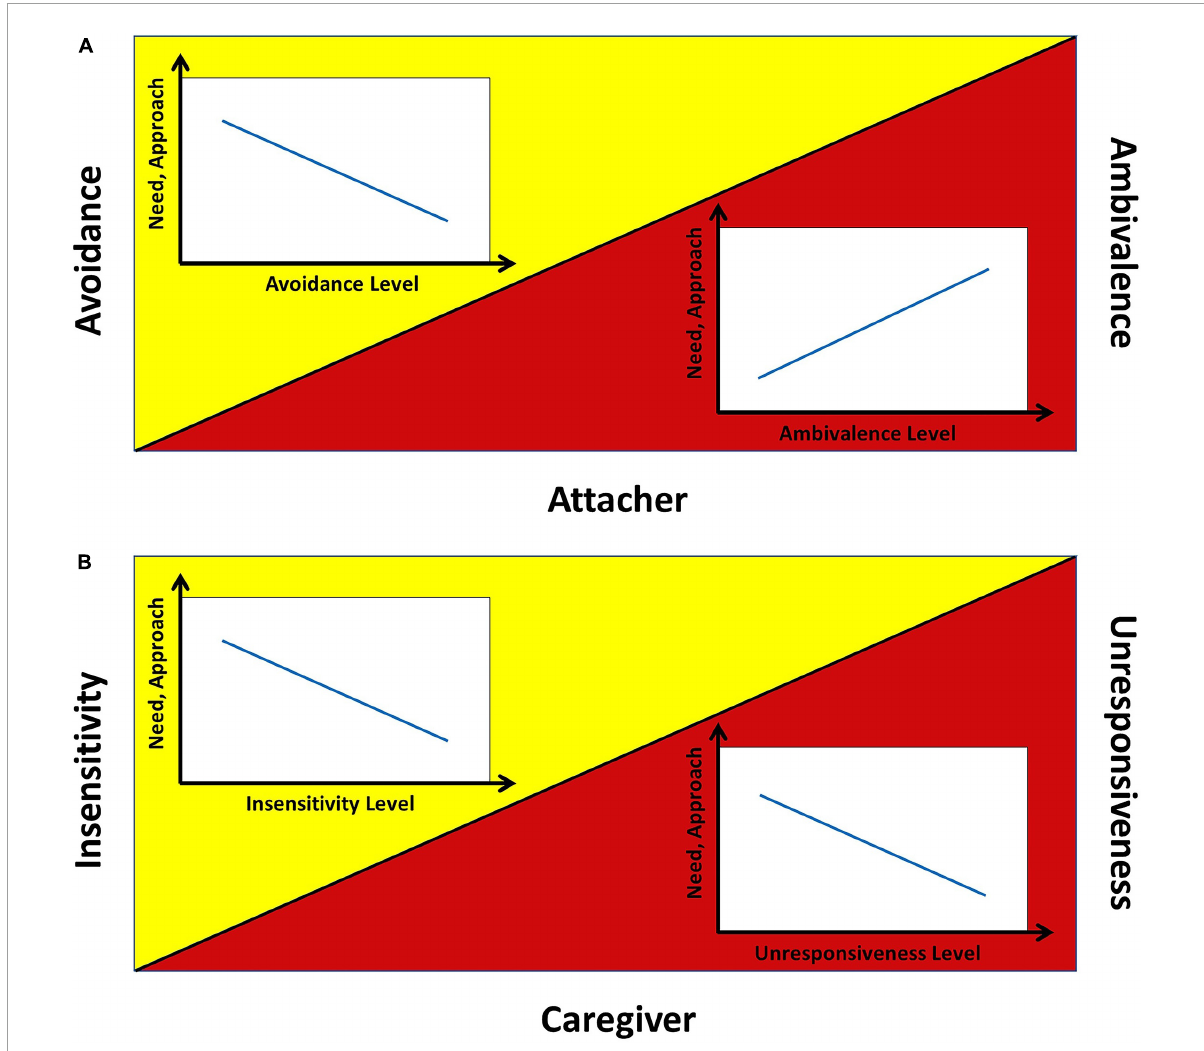
FIGURE1 Expected trends of attacher’s and caregiver’s need and approach. Following the literature, this figure represents indicative linear trends of need and approach: (A) in the attacher case, for avoidance (yellow side) and ambivalence (red side) and (B) in the caregiver case, for insensitivity (yellow side) and unresponsiveness (red side). Exploration always has the opposite